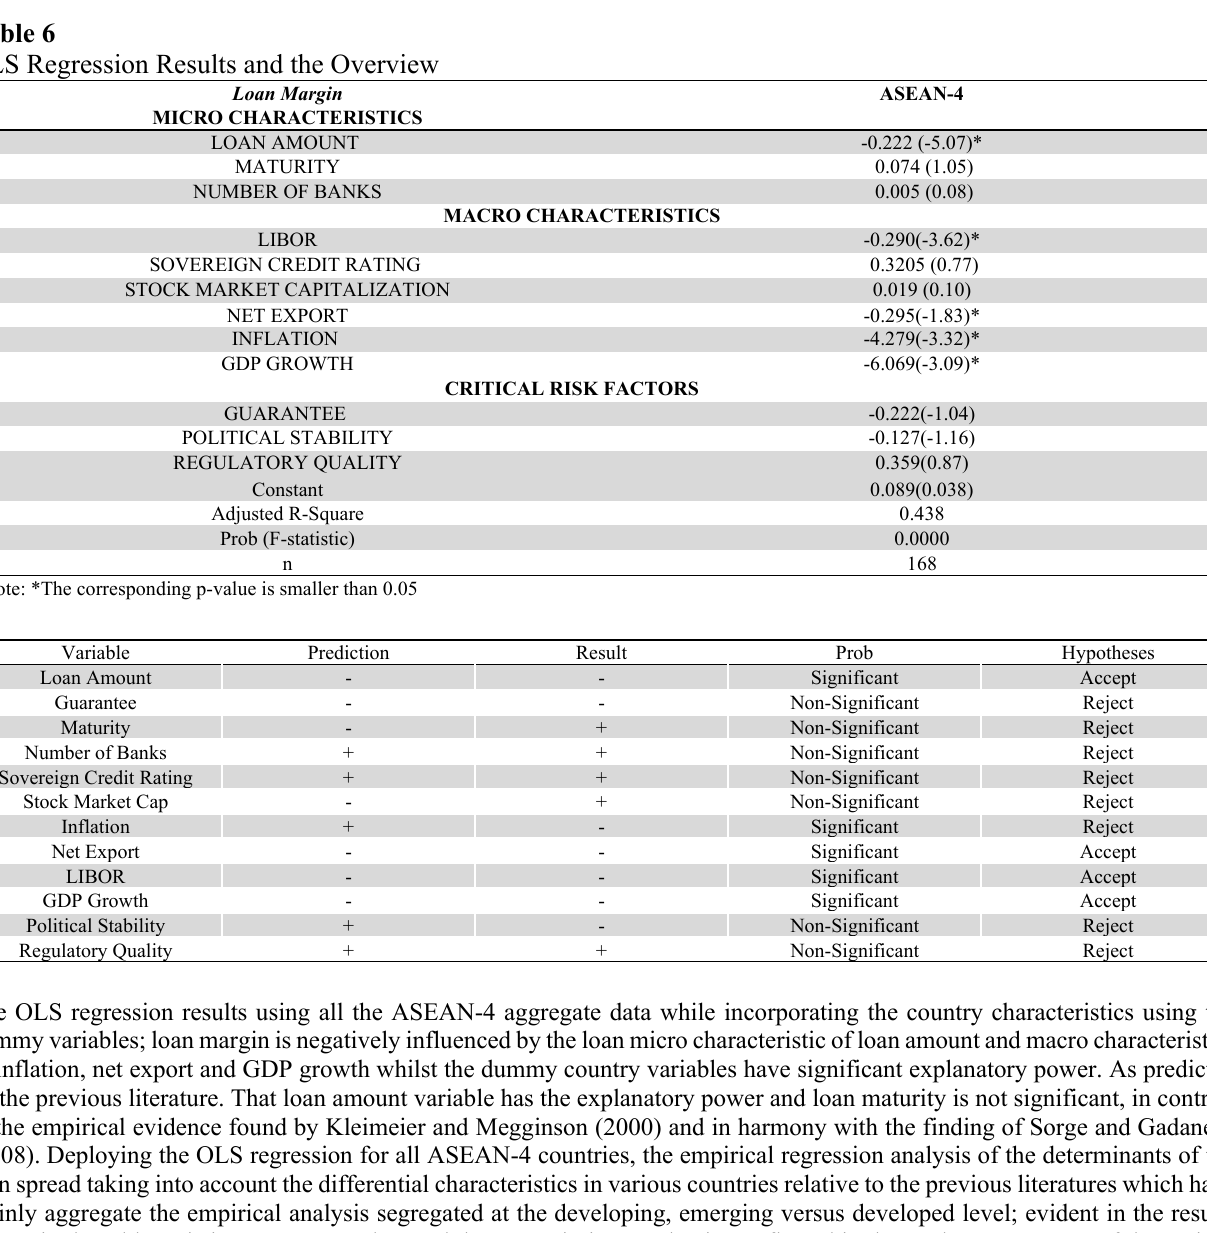
Full countries regression of the ASEAN-4